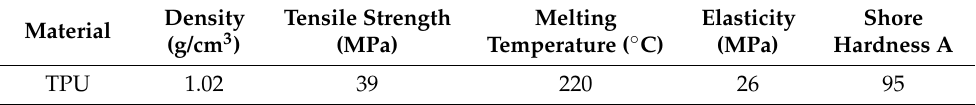
Table 2. Main mechanical and physical properties of TPU, provided by Manufacturer